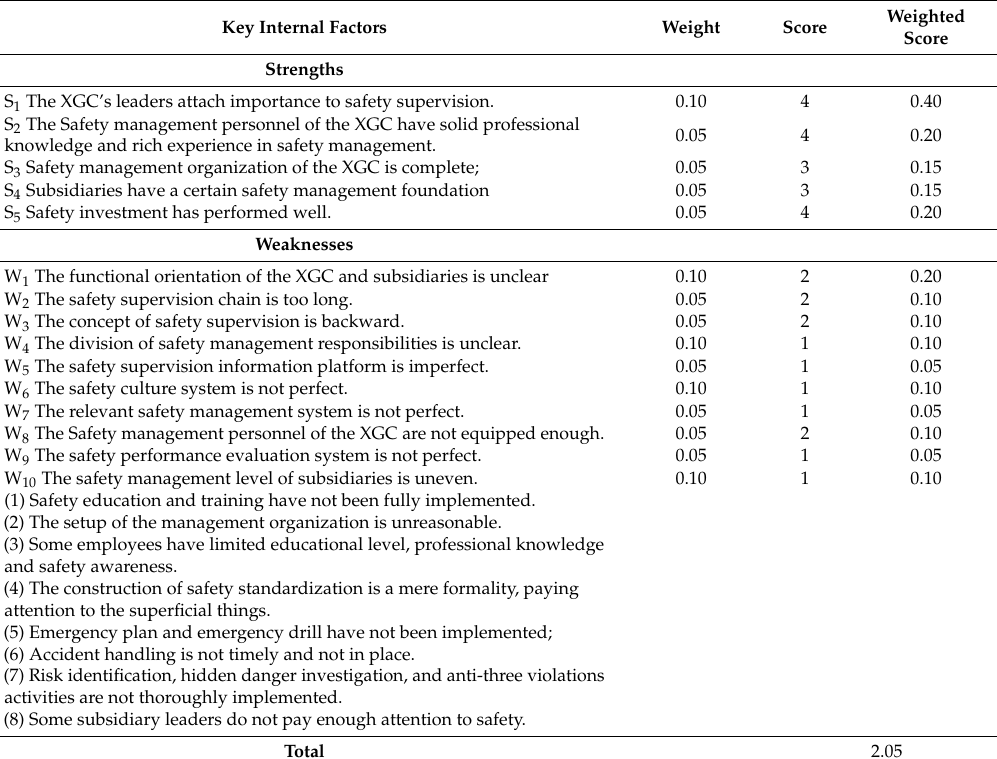
Table 2. Internal factor evaluation matrix (IFEM)